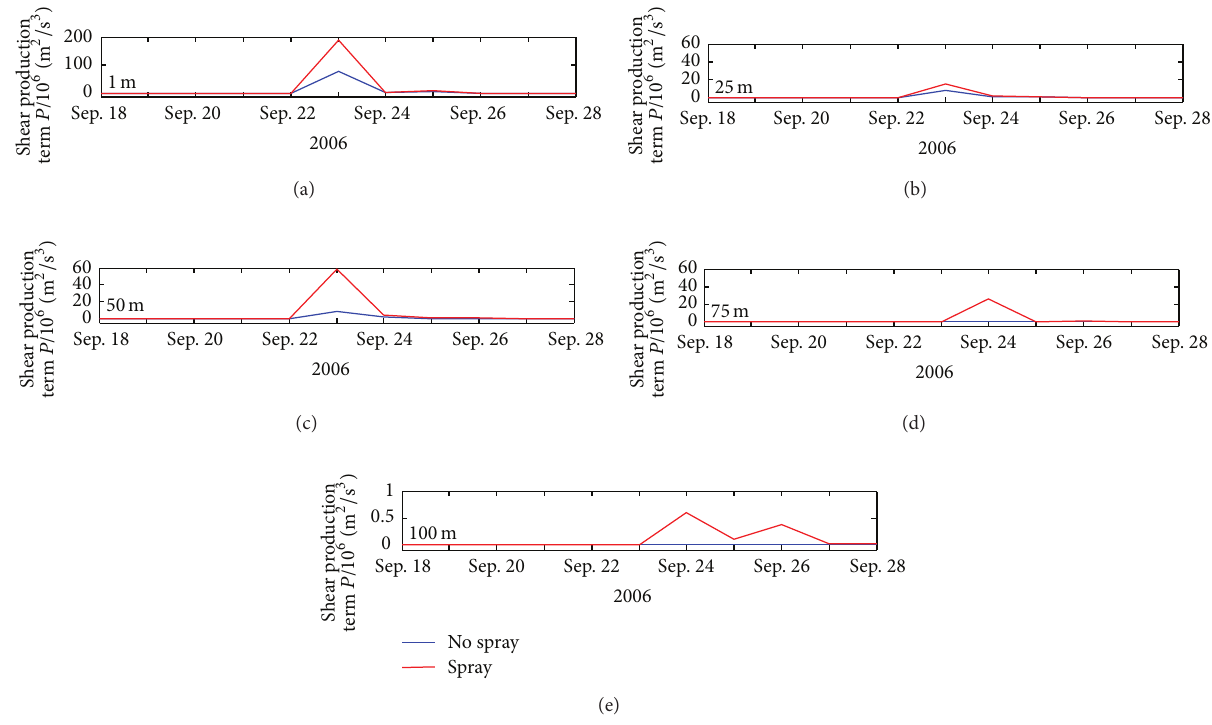
Figure 11: Time series (daily) of the shear production term 𝑃 from simulations with (red curves) and without sea spray (blue curves) at the KEO station in (a) 1m, (b) 25 m, (c) 50 m, (d) 75 m, and (e) 100 m depth.